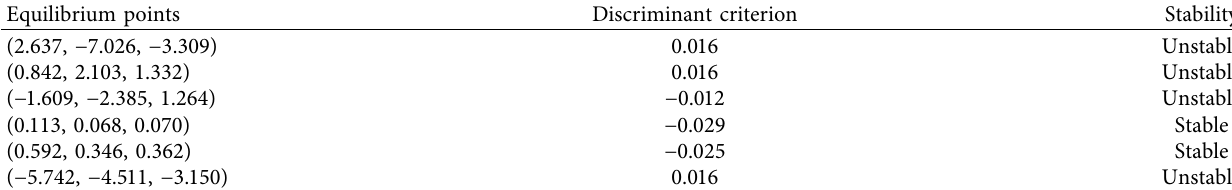
Table 2: Results of stability of the equilibrium